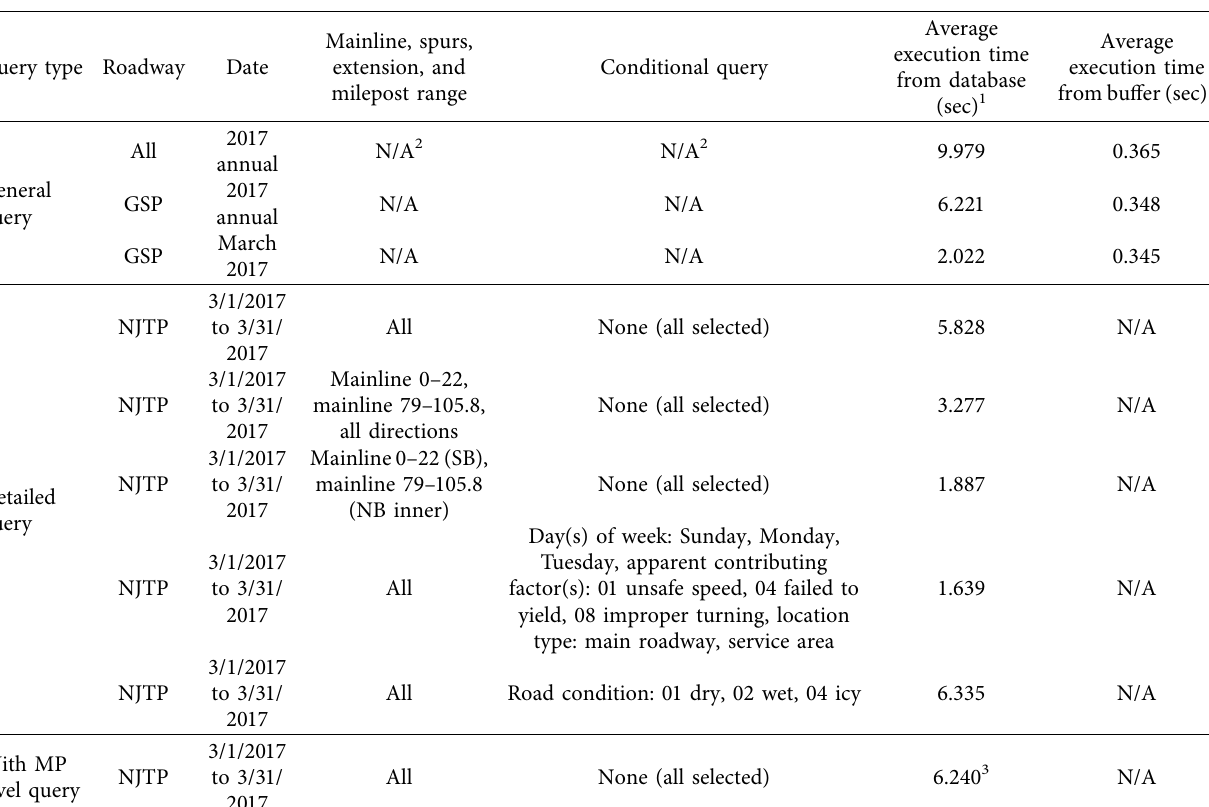
Figure 6: Crash rates of NJTP segments in March 2017. Table 2: Results of speed